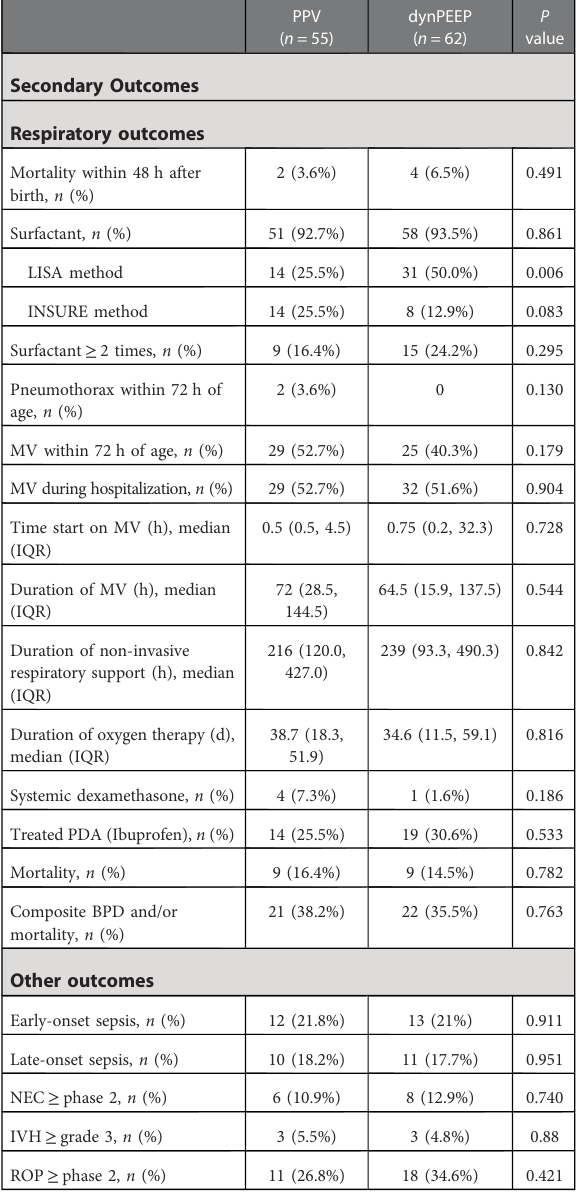
TABLE 4 The secondary outcomes (respiratory and other) of preterm infants with gestational Age less than 30 weeks who received PPV or DynPEEP in the